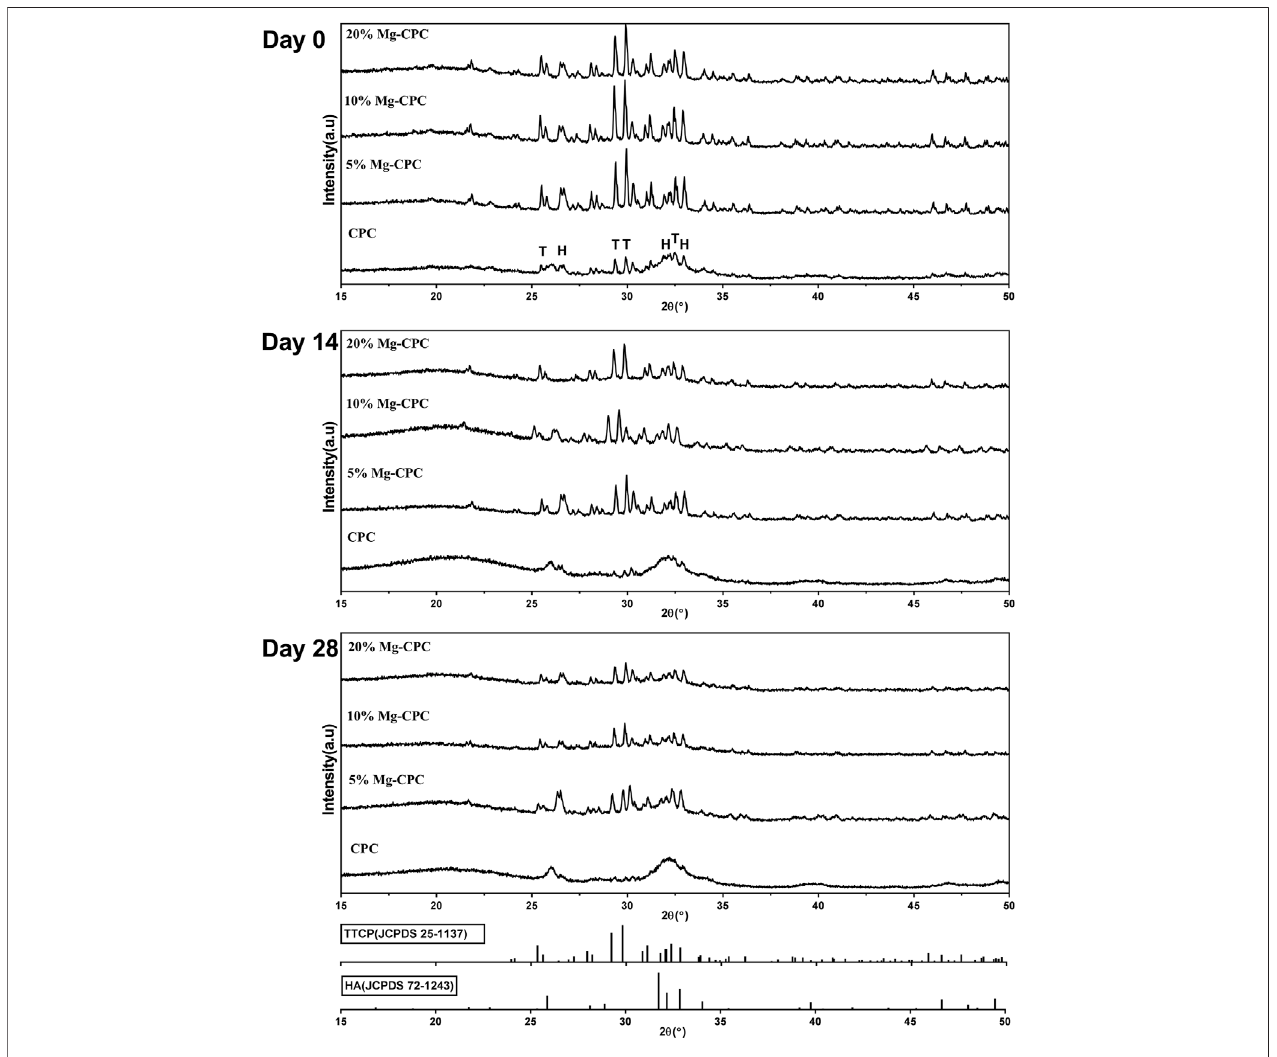
FIGURE 2 | XRD patterns of cement types. After immersion in SBF 0, 14, and 28 days, all the cement groups were freeze-dried to remove moisture and then ground into a powder for tested. The results were compared with the standard card of HA (JCPDS 72-1243) and TTCP (JCPDS 25-1137) (H: HA, T: TTCP).